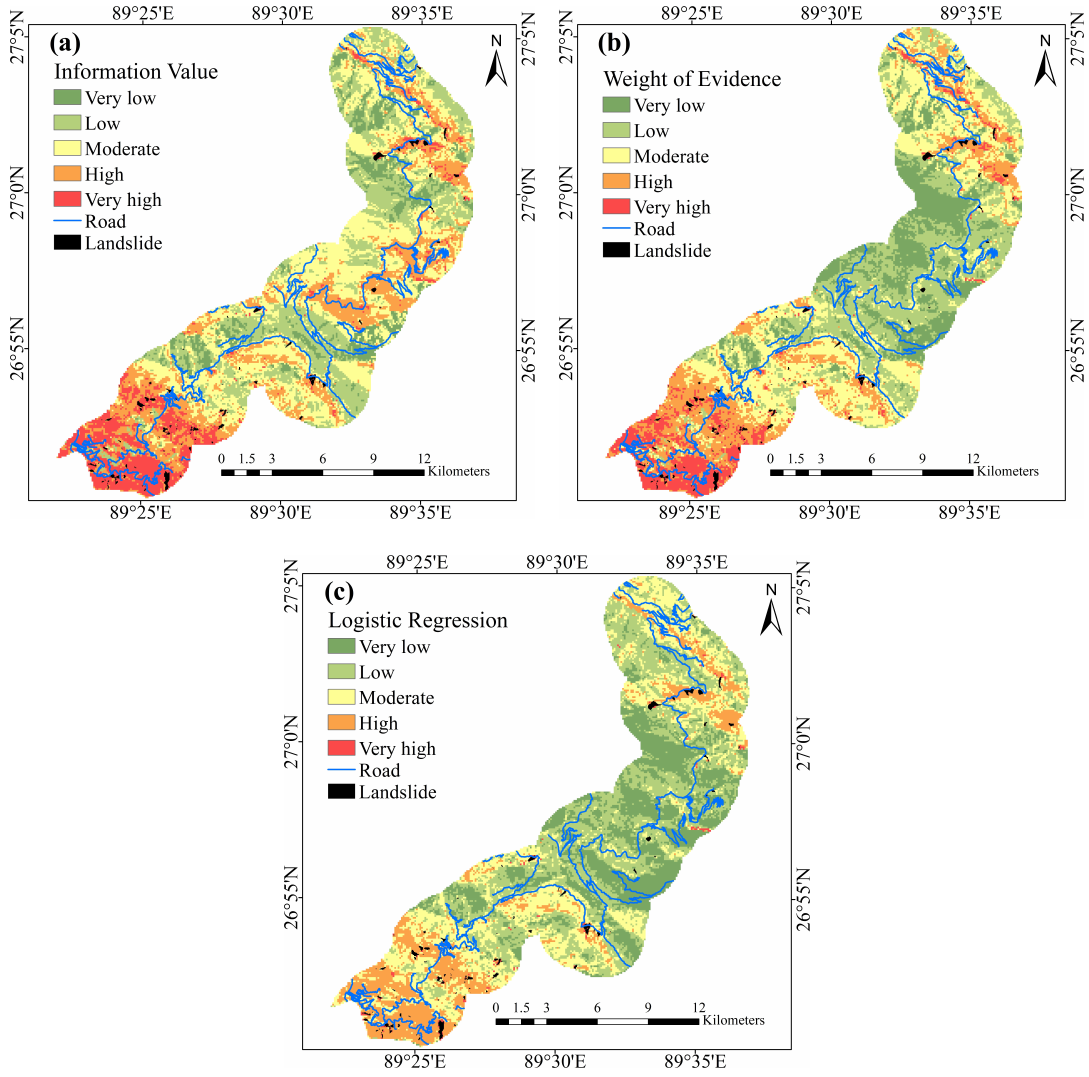
Figure 7. Landslide susceptibility maps produced for the 80.9 km Asian Highway (AH48) using: ( a ) information value, ( b ) weight of evidence, and ( c ) logistic